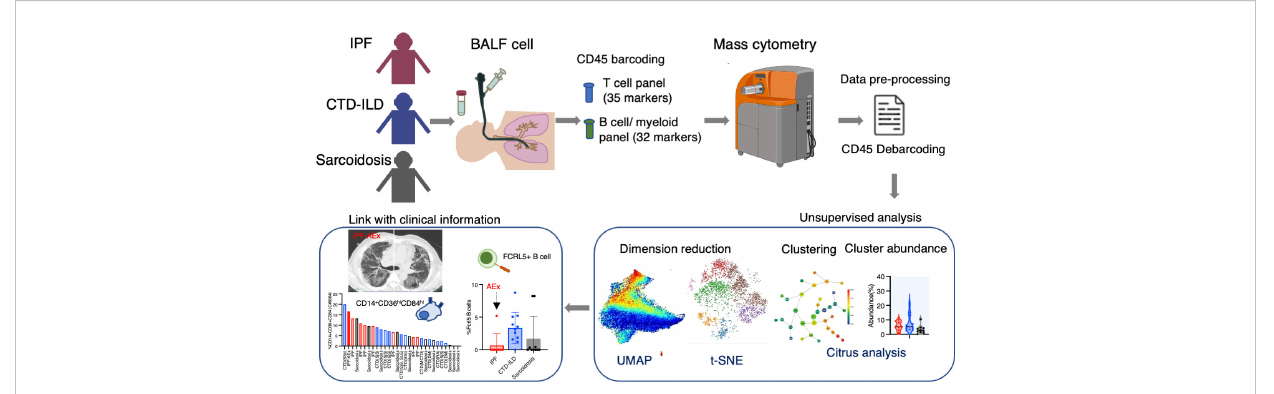
FIGURE 1 Graphical abstract of the study. Bronchoalveolar lavage fl uid (BALF) samples were collected from patients with idiopathic pulmonary fi brosis (IPF), connective-tissue disease (CTD)-related ILD, and sarcoidosis. Following CD45 barcoding for individual sample identi fi cation, BALF cells were analyzed with a T cell panel (35 markers) and B cell/myeloid cell panel (32 markers) using mass cytometry. The expansion of CD14 + CD36 hi CD84 hi monocyte populations was found in IPF and ILDs with a progressive phenotype. FCRL5 + B cells were increased in CTD-ILDs, acute exacerbation (AEx) of IPF, and sarcoidosis with advanced lung